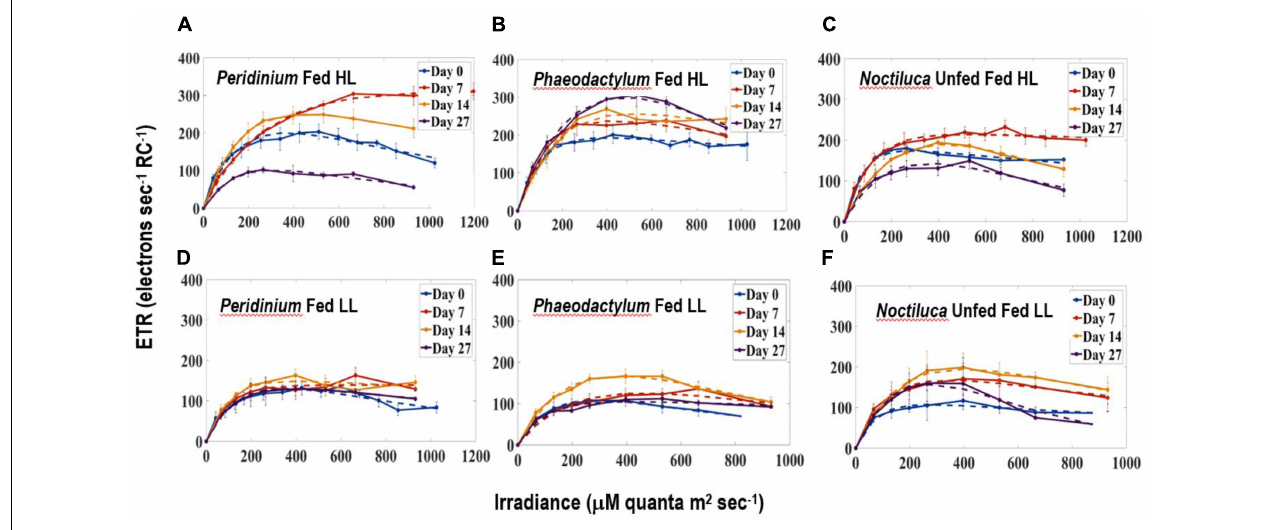
FIGURE 5 | Electron Transport Rates-Irradiance (ETR-E) curves for (A) P. foliaceum fed Noctiluca cells in HL (B) P. tricornutum fed Noctiluca cells in HL (C) Unfed Noctiluca cells in HL (250 µ E m - 2 s - 1 ) fitted to the function of Platt et al. (1980), as described in Section “Materials and Methods.” ETR is expressed as electrons s - 1 Reaction Center - 1 . (D–F) are for the same but exposed to LL (10 µ E m - 2 s - 1 ). Data points represent means ± SE ( n =